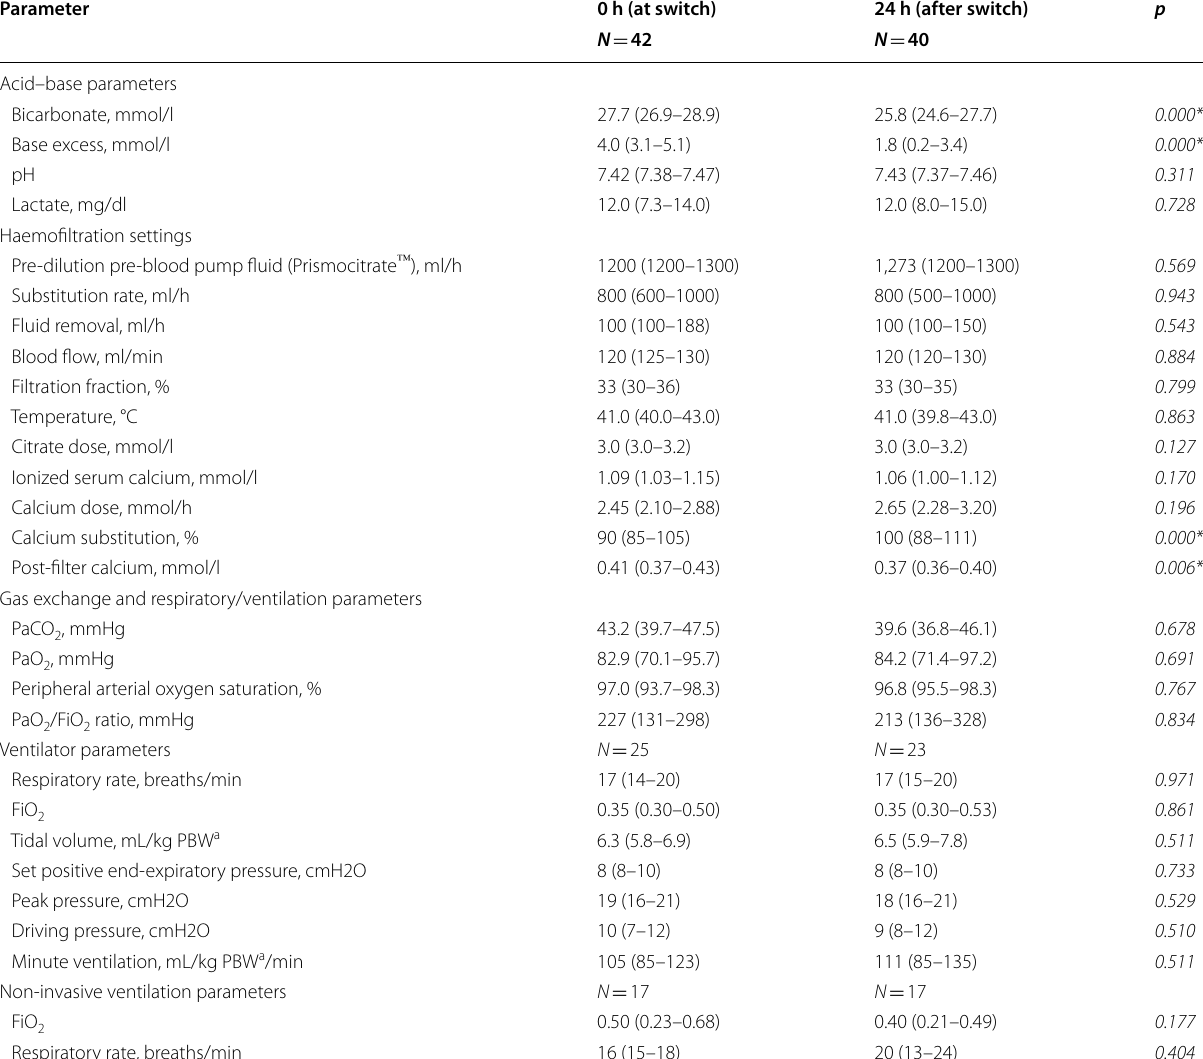
Table 3 Acid–base parameters, hemofiltration settings, gas exchange and respiratory/ventilation parameters